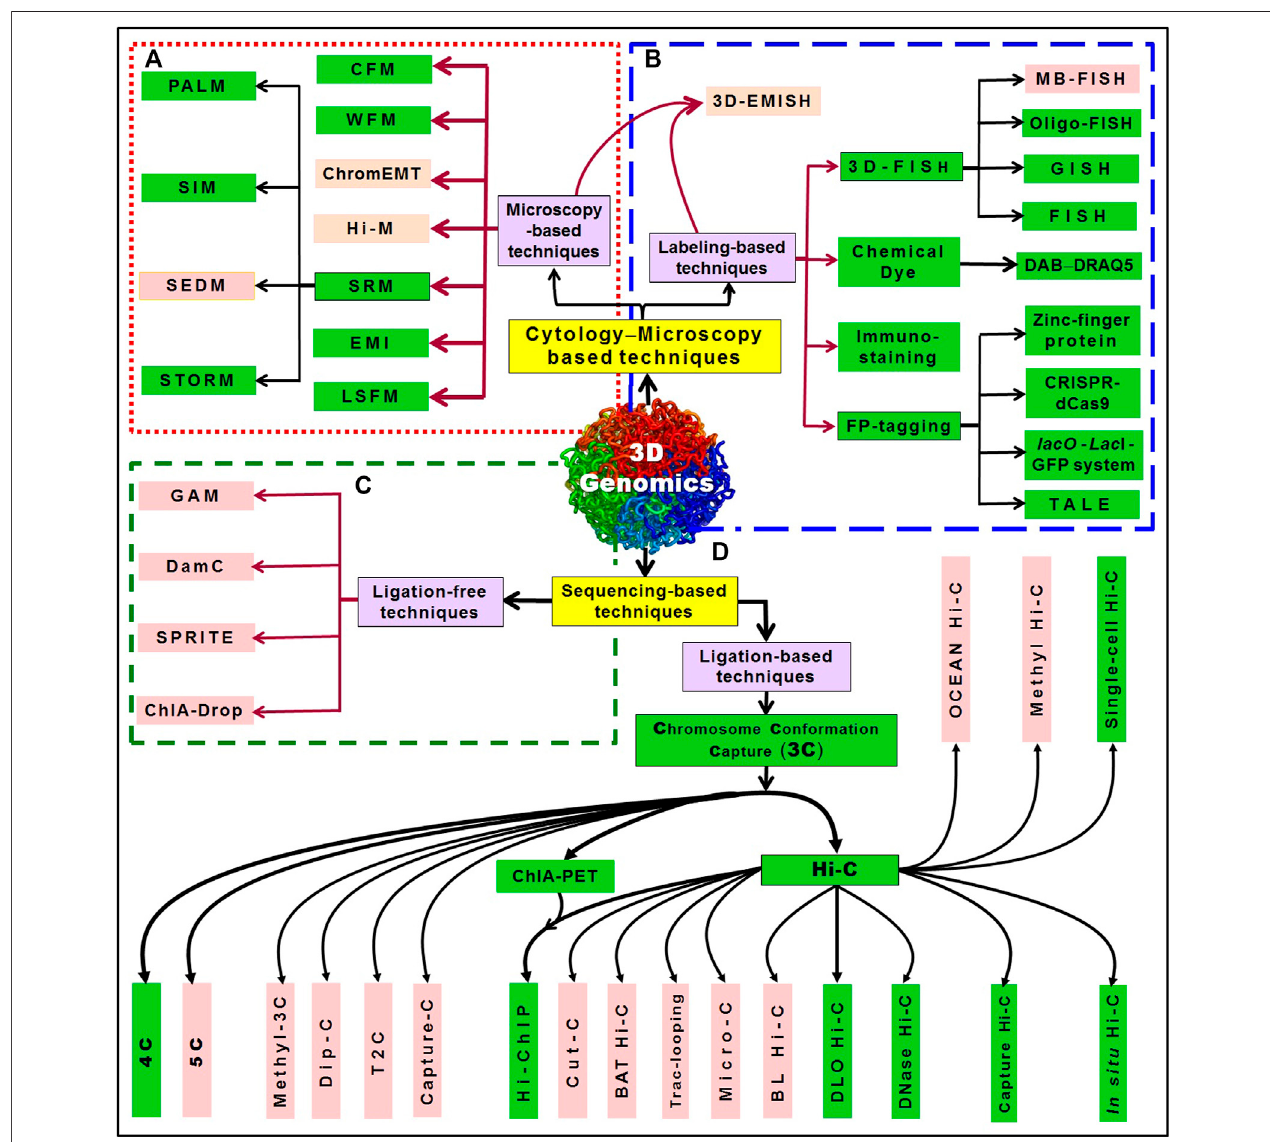
FIGURE 2 | An overview of 3D genomics techniques. The techniques can be broadly divided into two categories: one is based on cytological/microscopic examination/imaging; another is based on sequencing. (A) The microscopy-based techniques include WFM (wide- fi eld microscopy), CFM (confocal fl uorescence microscopy),ChromEMT(Chrom-electronmicroscopytomography),Hi-M(multiplexed,sequentialimagingapproach)simultaneouslyreveals3Dchromatinorganization and transcriptional activity, SRM (super-resolution microscopy), which include SIM (structured illumination microscopy), SEDM (stimulated emission depletion microscopy), PALM (photoactivated localization microscopy), STORM (stochastic optical reconstruction microscopy), EMI (electron microscopy imaging), and LSFM (light-sheet fl uorescencemicroscopy). (B) While3D-EMISH(three-dimensionalelectronmicroscopywith insitu hybridization)utilizestheadvantagesofbothmicroscopy (electron microscopy) and labeling ( in situ hybridization), the labeling-based techniques include 3D-FISH [such as fl uorescence in situ hybridization, MB-FISH (molecular beacon-FISH), Oligo-FISH (oligonucleotides probe-based FISH), GISH (genomic in situ hybridization)], staining with chemical dyes like DAB − DRAQ5 system, immune- staining,andFP-tagging( fl uorescentprotein-tagging)includingtaggingwithzinc- fi ngerprotein, lacO -LacI-GFPsystem,CRISPR-dCas9(clusteredregularlyinterspaced short palindromic repeats-nuclease-de fi cient Cas9), TALE (transcription activator-like effectors with a quantum dot labeling technique). The sequencing-based techniques can be ligation-free or those which require proximity ligation (3C, chromosome conformation capture). (C) While ligation-free techniques include GAM (genome architecture mapping) that combines micro-cutting and sequencing, SPRITE (split-pool recognition of interactions by tag extension), ChIA-Drop (chromatin interaction analysis via droplet-based and barcode-linked sequencing), DamC (DNA adenine methyltransferase-based chromosomal contacts), (D) ligation-based techniques include the advancements in 3C (chromosome conformation capture), like 4C, 5C (chromosome conformation capture carbon copy), methyl-3C (combinationofDNAmethylationdetectionand 3Ctechnology),Dip-C(combination ofsingle-cell3Candtransposon-basedwhole-genome ampli fi cation method),T2C (targeted Chromatin Capture), Capture 3C (combination of 3C with oligonucleotide capture technology. Further advancements like ChIA-PET (chromatin interaction analysisbypaired-endtagsequencing)andHi-C(high-throughputchromosomeconformationcapture),andtheircombinationHi-ChIP(chromatinconformationmethod that combines Hi-C with ChIA-PET technology) have advanced the 3D genome architectures. Combination of techniques like Cut-C (antibody-mediated cleavage by ( Continued )